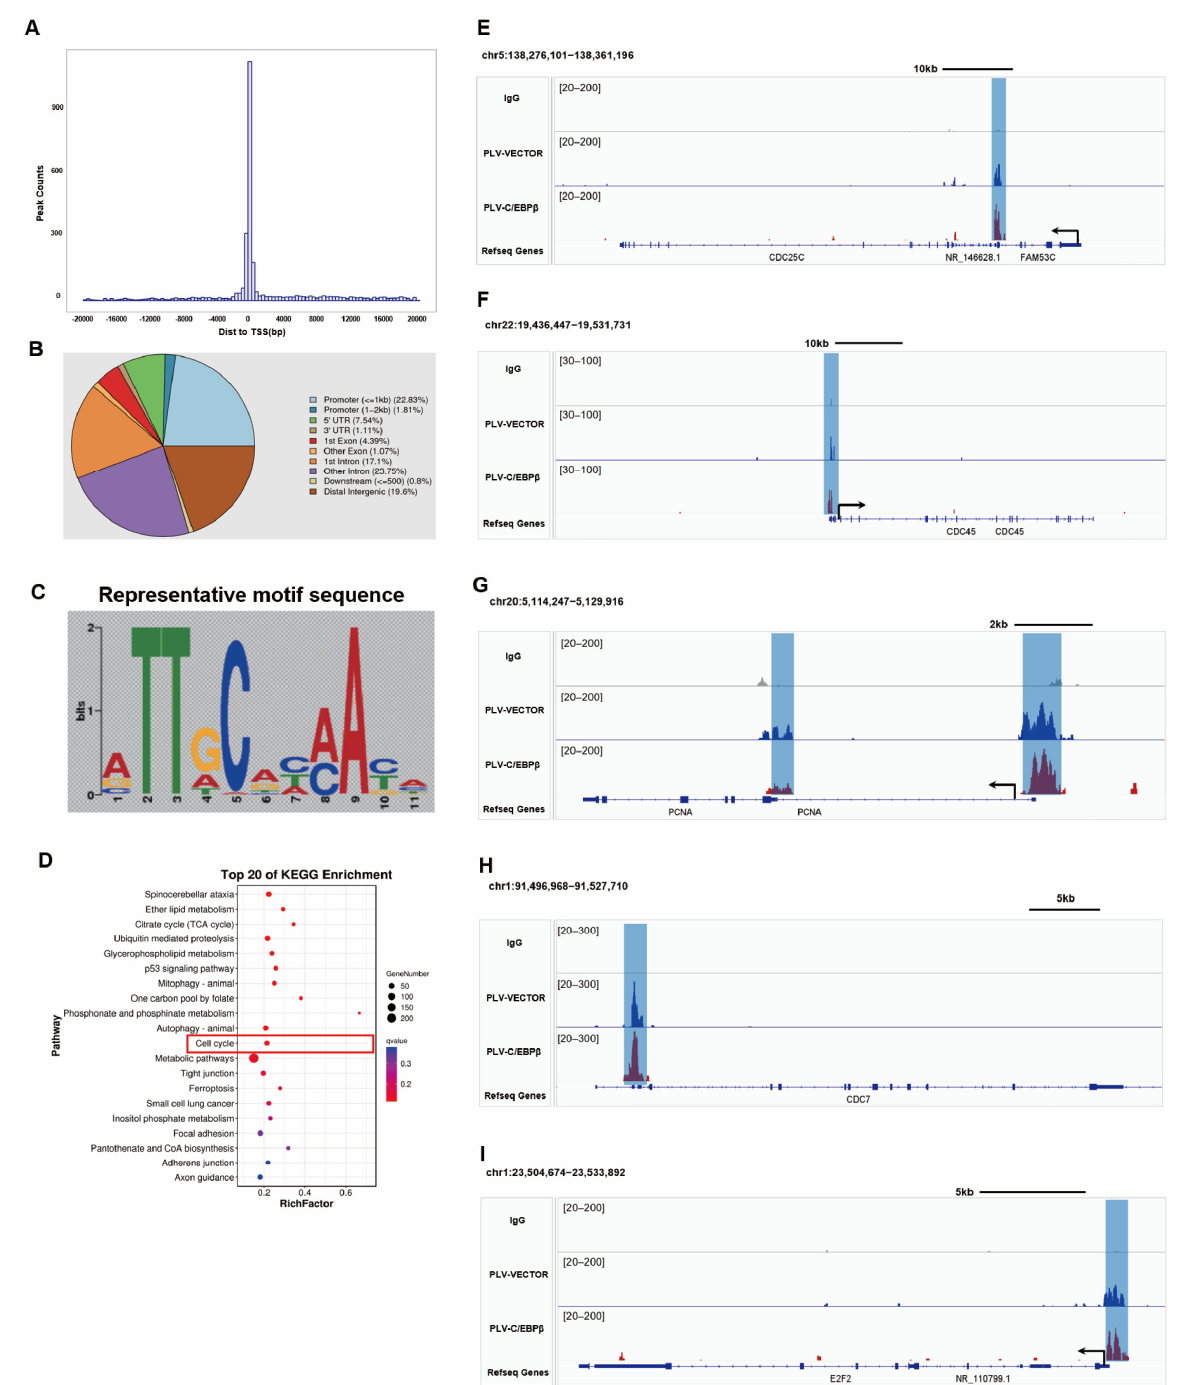
Figure 6. C/EBPβ promoted the expression of proliferative genes by binding to promoter regions. ( A ) CUT&Tag data analysis for peak summit of relative genes at location map, the abscissa was the distance between peak summit and TSS site, and the ordinate was the number of peaks. ( B ) Pie chart of peak distribution on gene functional elements. ( C ) Top scoring and representative motif sequence of C/EBPβ binding sites. ( D ) KEGG enrichment bubble diagram to show the first 20 pathways with the smallest q values, pathway shown as the ordinate and rich factor shown as the abscissa (the number of differences in this pathway divided by all the numbers). The size indicated the number; the redder the color, the smaller the q value. ( E – I ) The peaks of individual proliferative genes, including CDC25C, CDC45L, PCNA, CDC7, and E2F2, were enriched in the transcriptional regulatory regions of their respective genes, and the peaks of some genes were enhanced after overexpression of C/EBP β